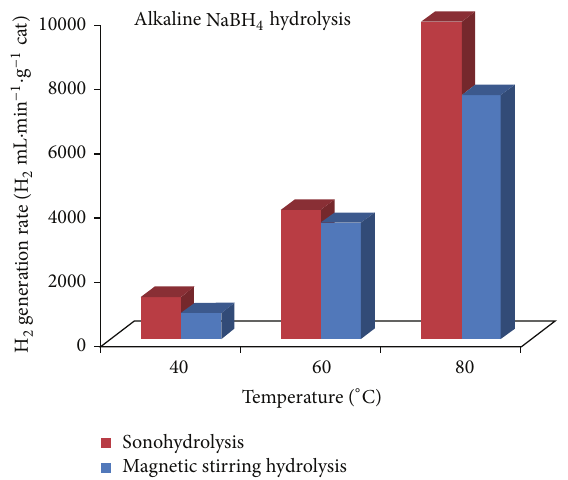
Figure6:Hydrogengenerationratecomparisonversustemperature for sonohydrolysis and magnetic stirring hydrolysis of alkaline (10wt.%) 0.12 NaBH 4 solutions in presence of 0.5 mg CoB-1 catalyst. solution and CoB-1 catalyst. During the sonohydrolysis, cavitation bubbles created high energy effects and this caused continuous acceleration of hydrogen generation rate [19].